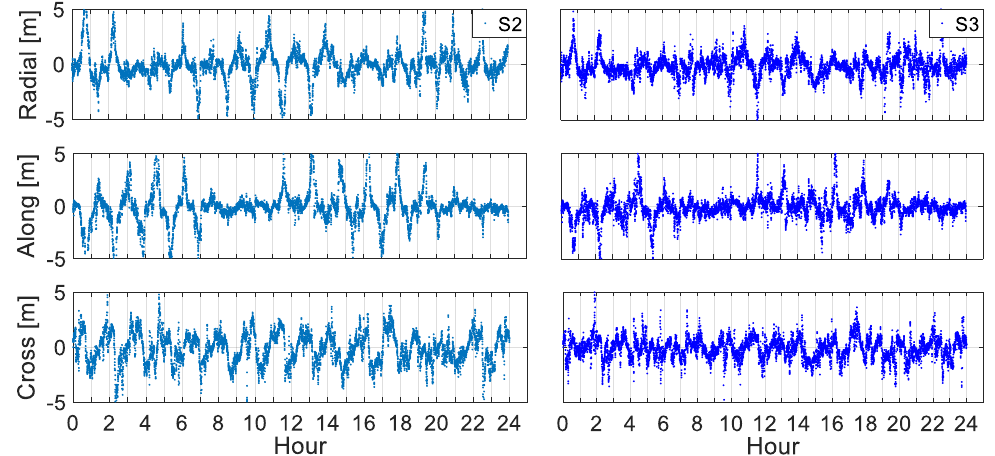
Figure 6. Swarm-A real-time POD results of Schemes 2 ( left ) and 3 ( right ).